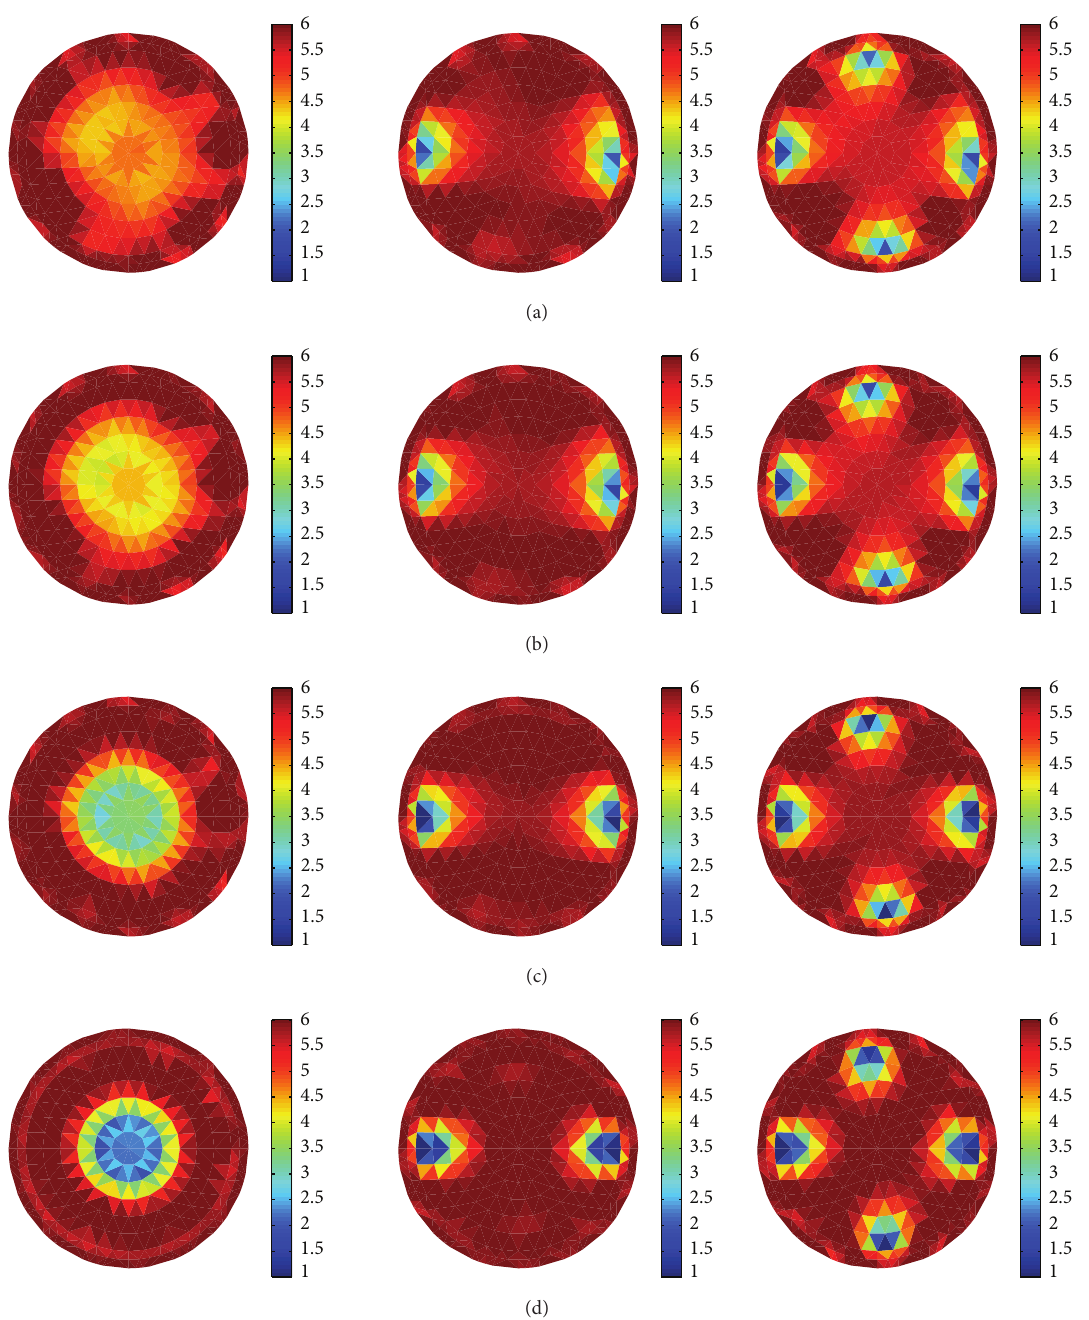
Figure 6: Reconstruction results by HPIM for three phantoms with different noise levels. (a) 𝜀 = 5 %; (b) 𝜀 = 3 %; (c) 𝜀 = 1 %; (d) 𝜀 = 0.5